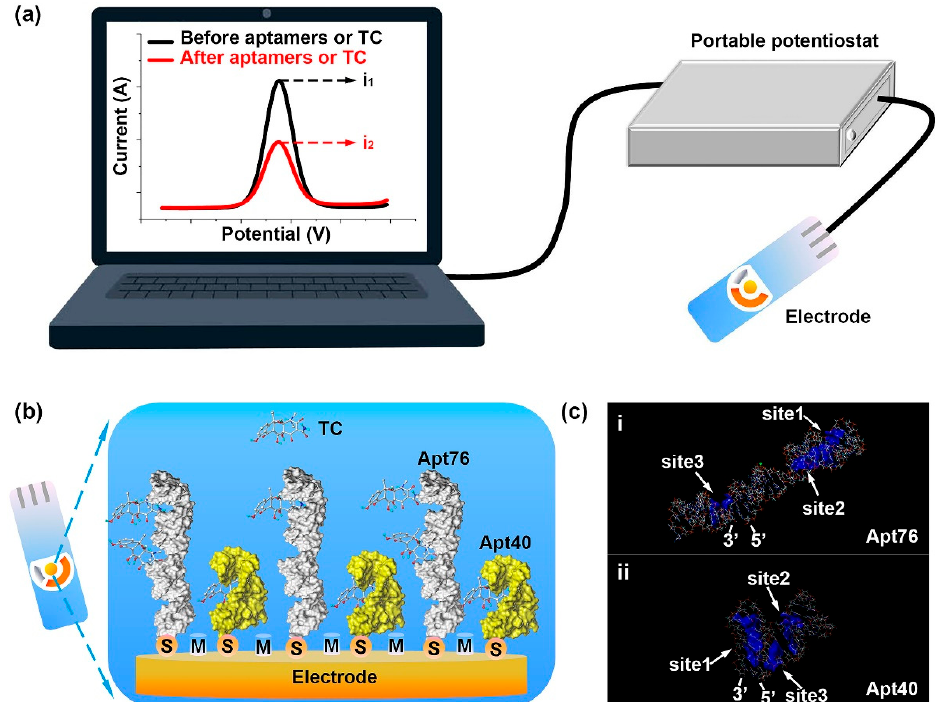
Figure 11. Scheme of the aptamer cocktail-based electrochemical aptasensor. ( a ) The electrochemical sensor was composed of a portable potentiostat, a computer, and an aptamer cocktail functionalized- electrode. ( b ) Working area of the aptamer cocktail-functionalized electrode. Thiolated-Apt76 and thiolated-Apt40 were co-immobilized on the surface of the electrode through S-Au interaction to the capture TC, followed by blocking with mercaptoethanol. S is thiol group; M is ME, 2-mercaptoethanol. ( c ) Predicted binding sites of Apt76 (i) and Apt40 (ii) for TC [178]. Reprinted with permission from [178] Copyright 2019